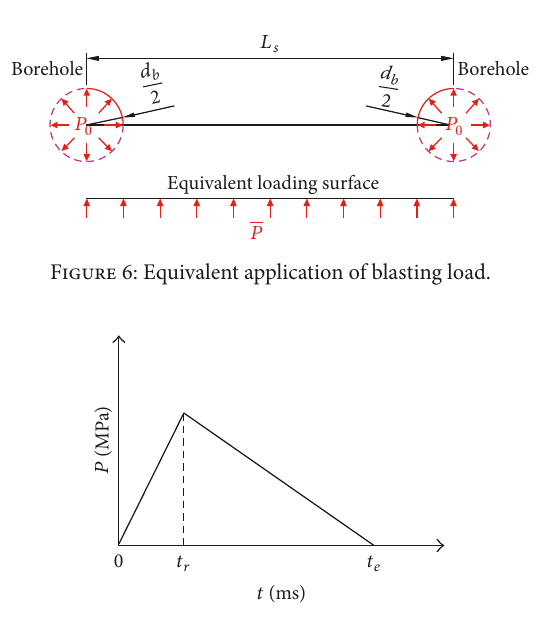
Figure 7: Blasting load applied to excavation contour. ( Note . Peak load at 𝑡 𝑟 is 53.6 MPa, and 𝑡 𝑟 = 2.3 ms and 𝑡 𝑟 = 17.0 ms, as calculated according to Lu et al. [24].)